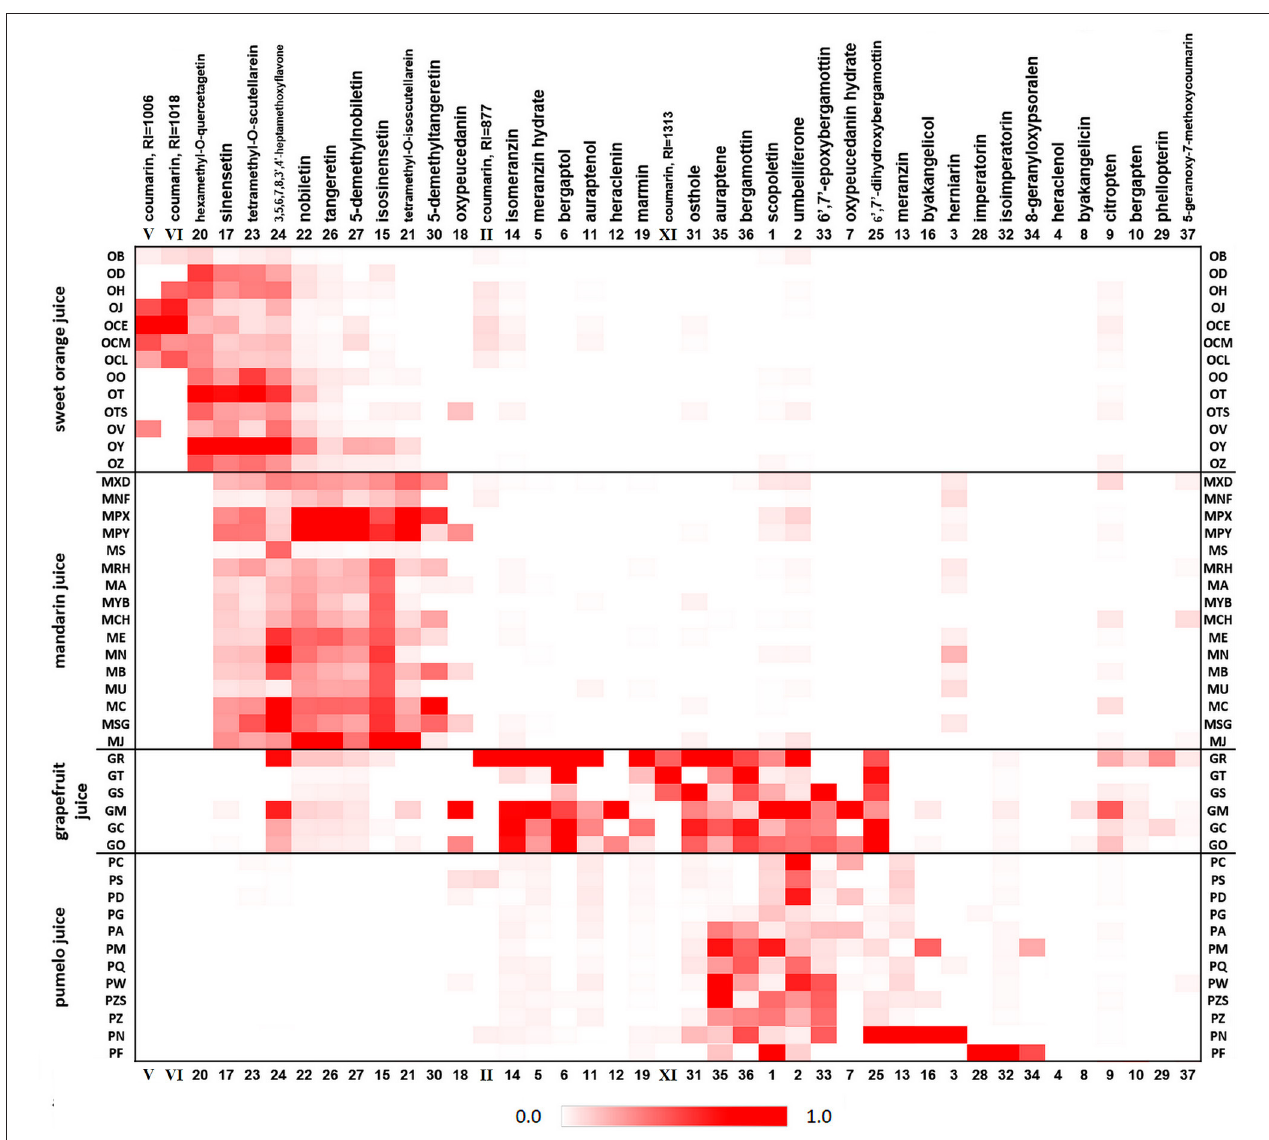
FIGURE 3 | Heat map displaying OHAs distribution profile and relative weight in the pasteurized juices of 47 citrus cultivars. Concentration of each compound was normalized across all samples, the highest amount set as 1.0, to better show the interspecific difference. Compounds II, V, VI, and XI, the tentatively identified coumarins, were calculated using their fluorescence emission responses. Abbreviated name for juice samples correspond to Supplementary Table 1 .